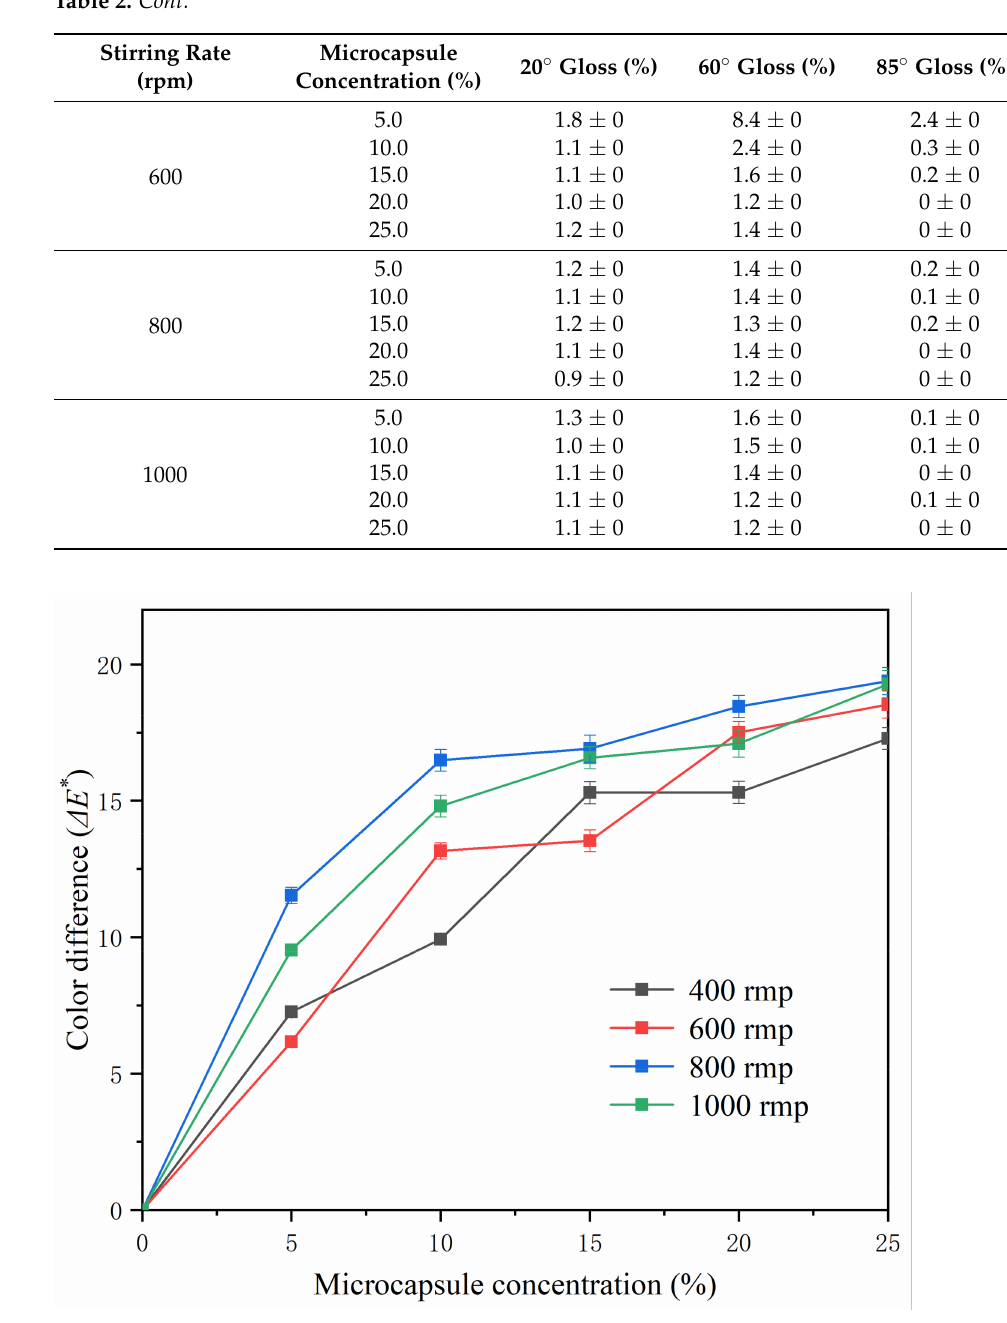
Figure 5. Effect of microcapsules on the color difference of waterborne primer